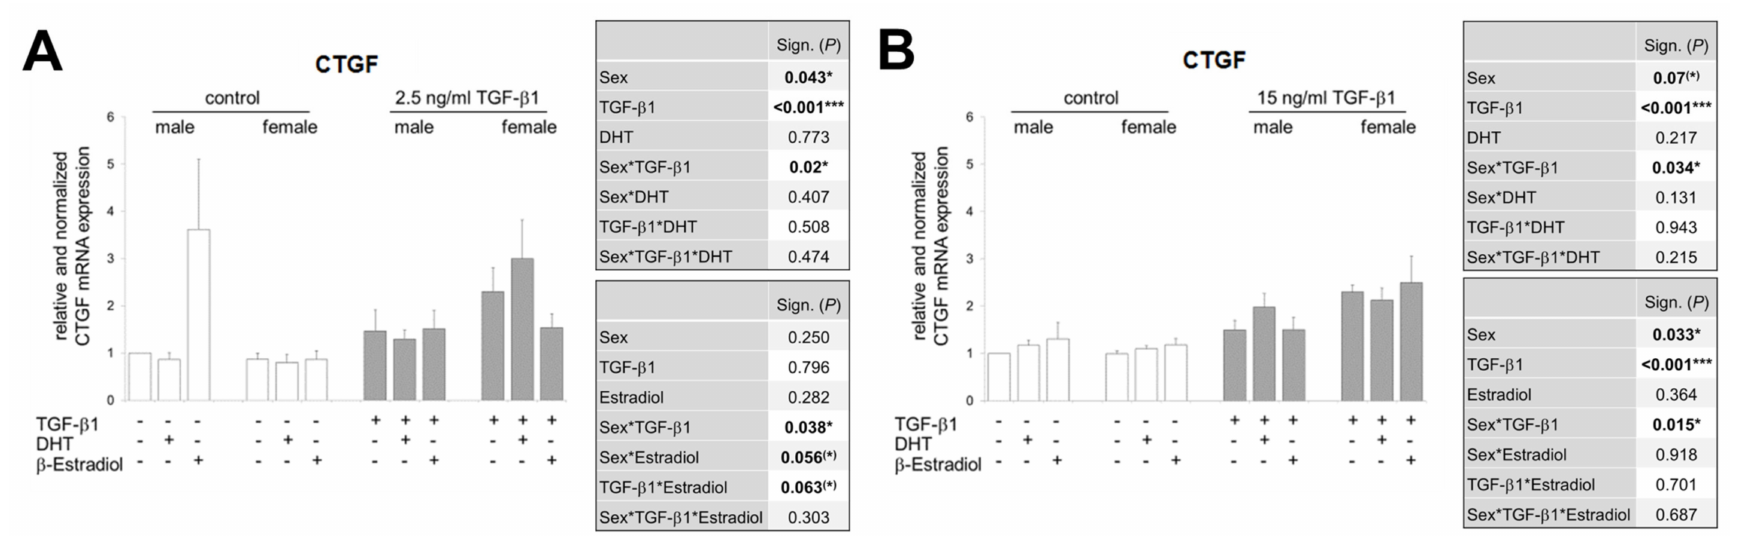
Figure 6. E ff ect of TGF- β 1 stimulation on CTGF mRNA expression in renal tissues. ( A ) CTGF mRNA analysis. Both kidneys of each of female / male ( n = 5 each) wildtype mice were minced pairwise, put into culture under control or 2.5 ng / mL TGF- β 1 and with or without sex hormones for 24 h, as indicated. ( B ) CTGF mRNA analysis. Both kidneys of each of female / male ( n = 6 each) wildtype mice were minced pairwise, put into culture under control or 15 ng / mL TGF- β 1 and with or without sex hormones for 24 h, as indicated. ( A , B ) The significances, shown in the upper table, were assessed using three-way ANOVA with sex (male or female), TGF- β 1 (control or 2.5 or 15 ng / mL) and DHT as the three factors. The significances, shown in the lower table, were assessed using three-way ANOVA with sex (male or female), TGF- β 1 (control or 2.5 or 15 ng / mL) and estradiol as the three factors. Sex, TGF- β 1, DHT, Estradiol: main e ff ect of sex / TGF- β 1 / DHT / Estradiol, respectively. Sex*TGF- β 1, Sex*DHT, TGF- β 1*DHT, Sex*Estradiol, TGF- β 1*Estradiol: interaction (determines whether the one main e ff ect depends on the level of the other main e ff ect). Sex*TGF- β 1*DHT, Sex*TGF- β 1*Estradiol: interaction (determines whether the third factor modifies the interaction between the other two factors). * P ≤ 0.05; *** P ≤